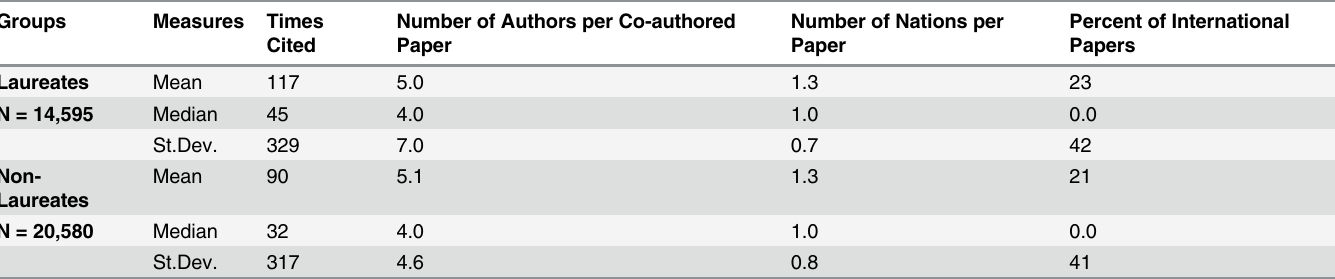
Table 2. Descriptive Statistics at Paper Level by Laureates and Non-Laureates.